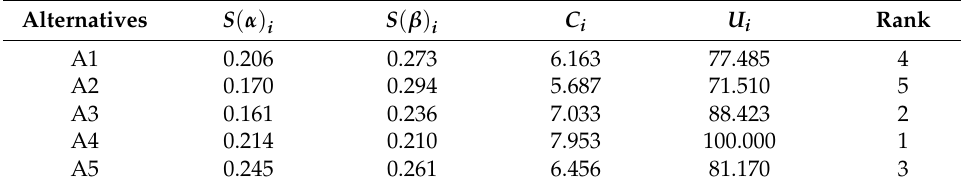
Table 11. The results of